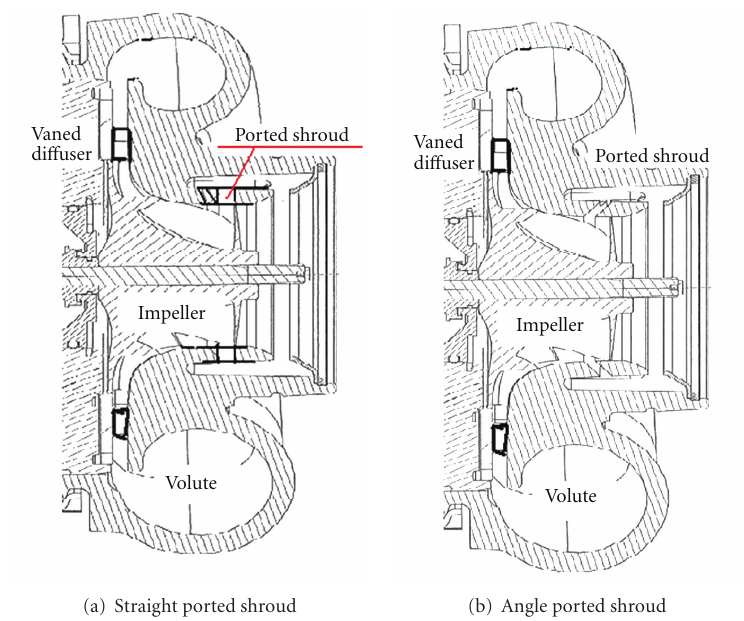
Figure 27: Ported shroud compressor.